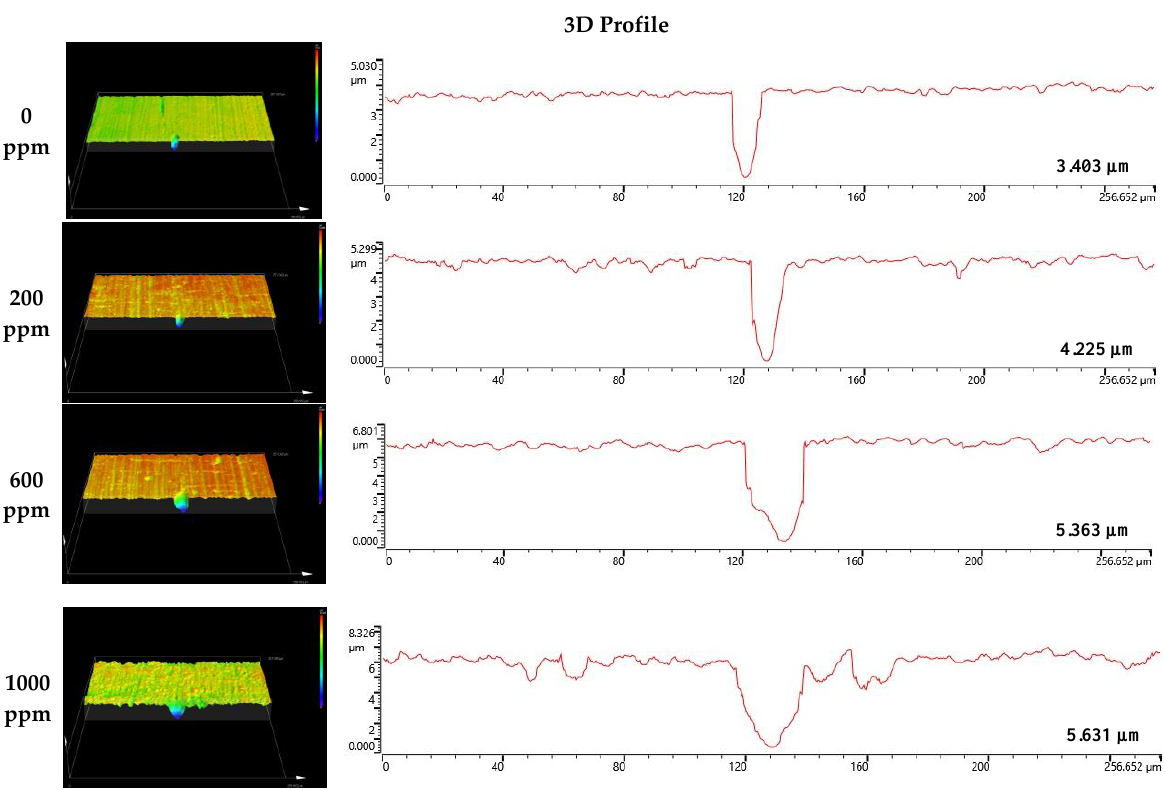
Figure 8. 3D analysis of damaged surface for 304 stainless steel after a potentiodynamic polarization experiment.